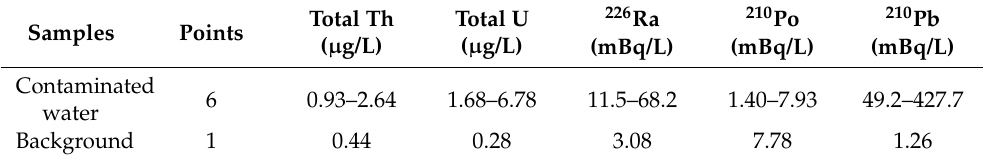
Table 4. Radioactivity concentrations in rivers.